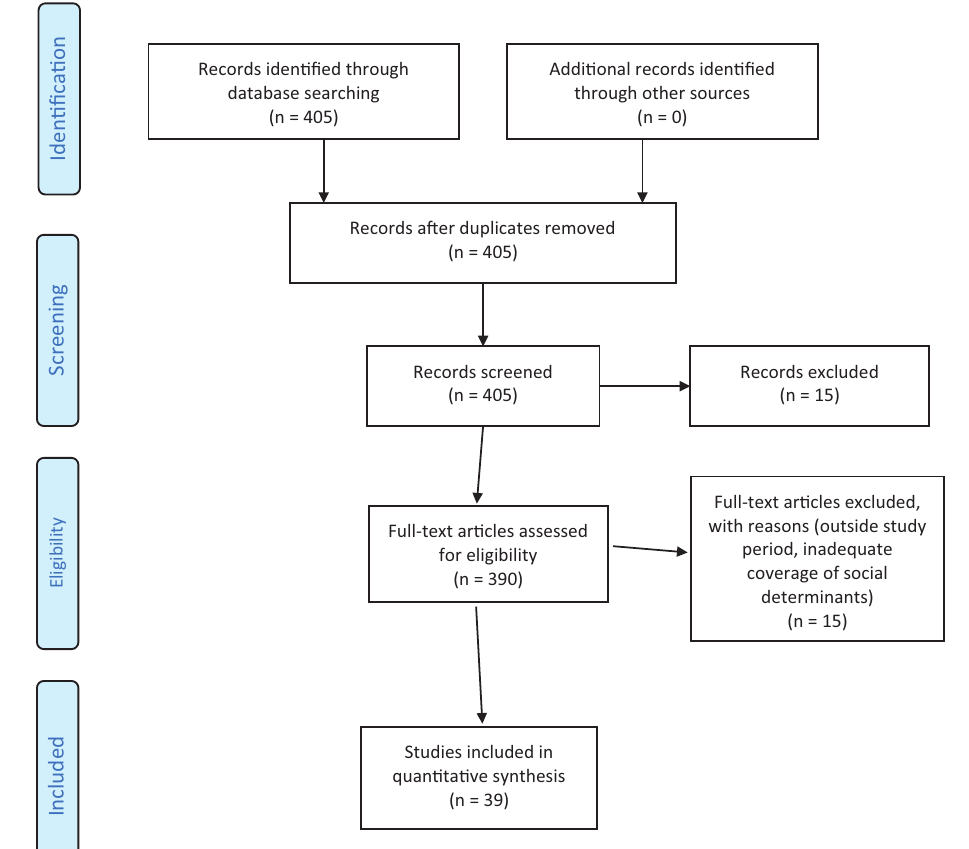
Figure 1: Flow Diagram Showing Results of the Selection Process Related to the Opioid Literature Review